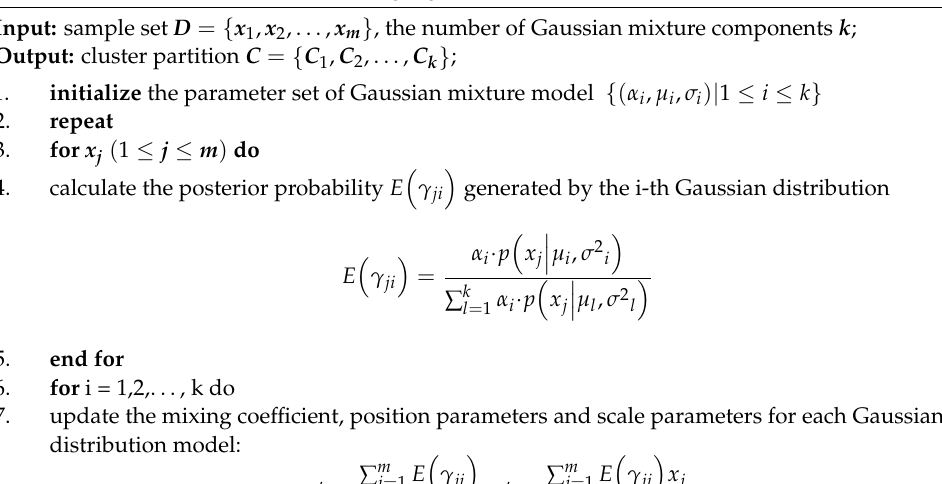
Algorithm 1 Gaussian mixture clustering